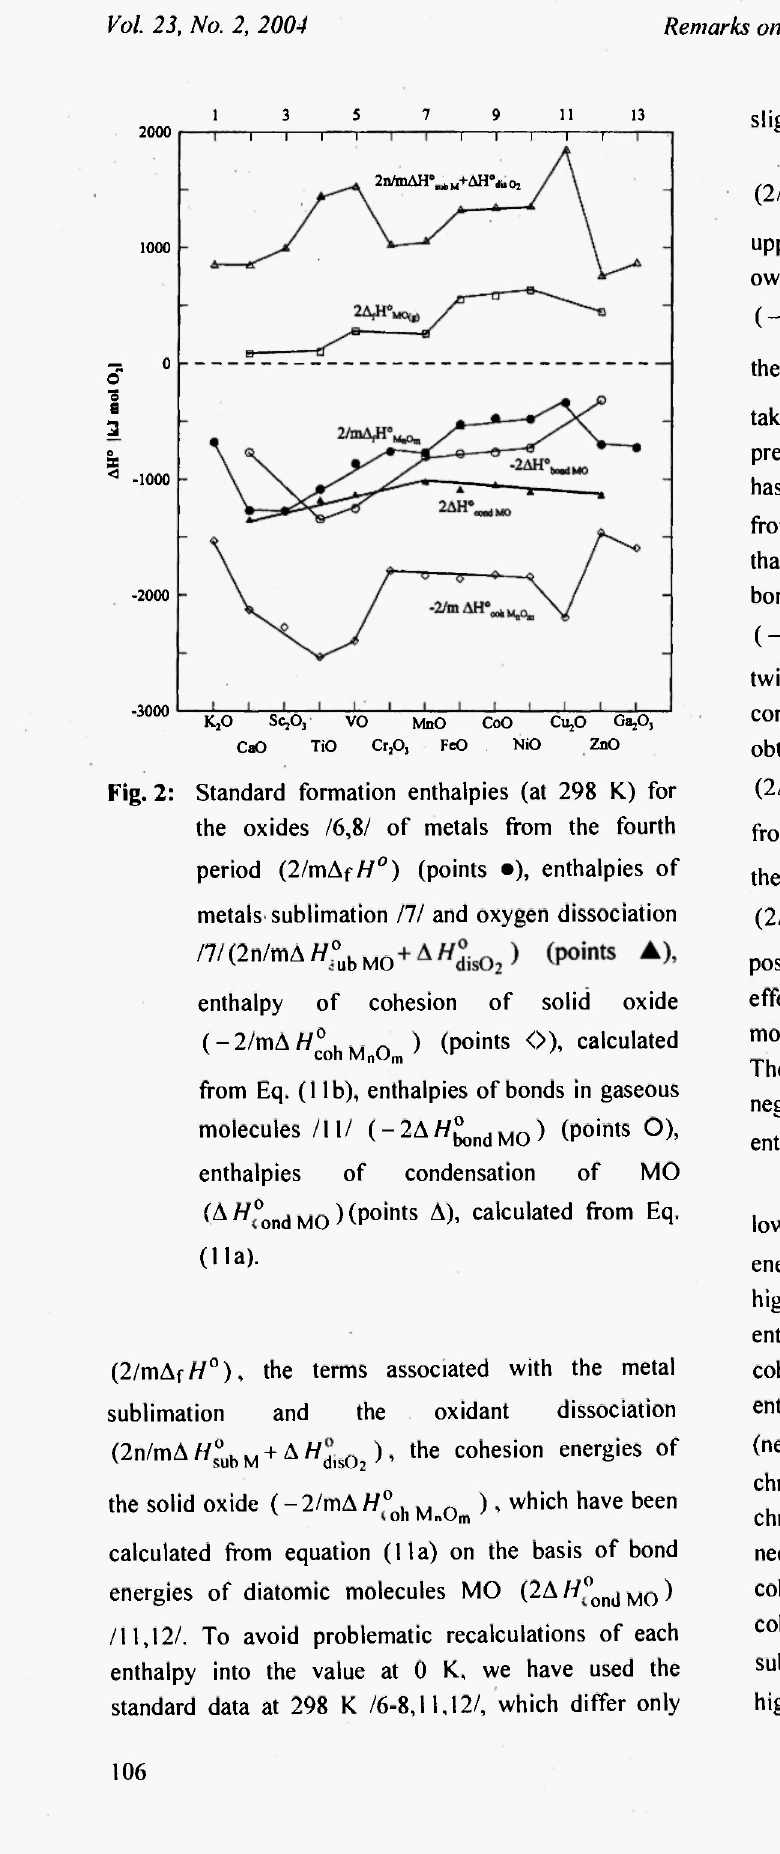
NiO Fig. 2: Standard formation enthalpies (at 298 K) for the oxides /6,8/ of metals from the fourth period (2/mAf H°) (points ·), enthalpies of metals sublimation 111 and oxygen dissociation Γ1Ι (2n/mA H° ub MO positive and range from 10 to 500 kJ, so that the heat effect associated with the formation of a gaseous cohesion